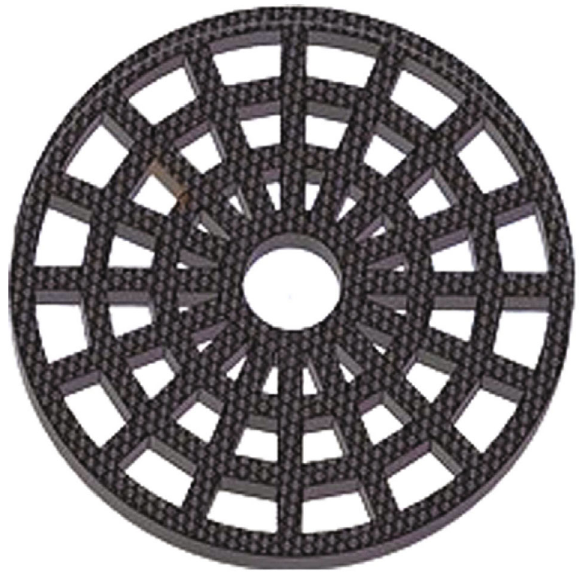
Figure 3: The structure of the spider web bu ff er